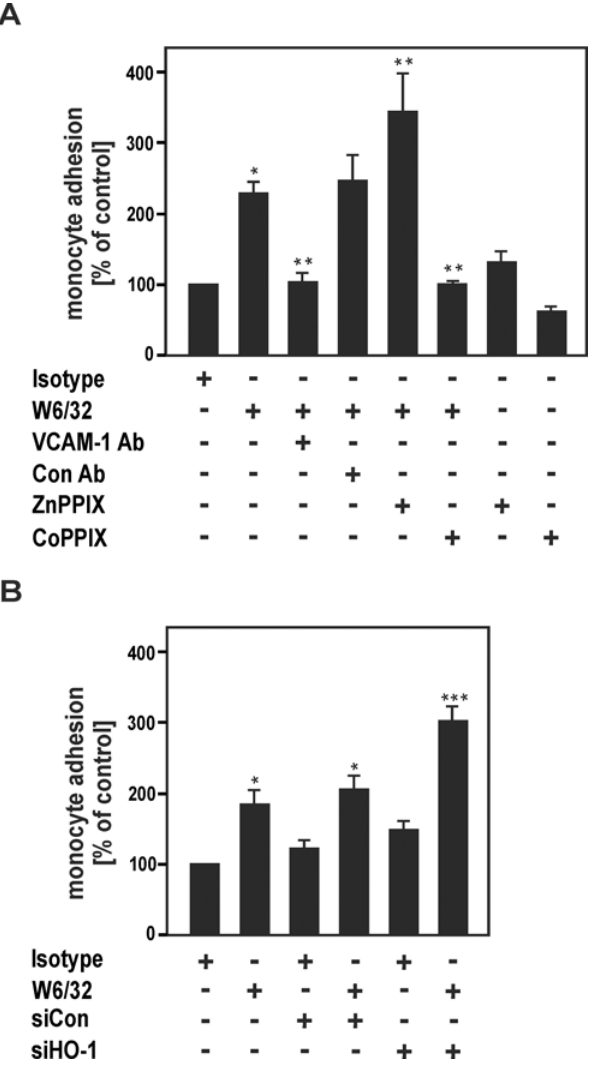
Fig 5. HO-1 modulates HLA I Ab-dependent up-regulation of THP-1 monocyte adhesion to HUVECs. (A) Confluent HUVECs were cultured for 24 h in the presence of MoAb W6/32 or isotype control Ab (10 μ g/ml) in the presence or absence of a blocking antibody against VCAM-1, a control Ab (Con Ab), ZnPPIX (5 μ M) and CoPPIX (5 μ M), as indicated. (B) HUVECs were transfected with siRNA for HO-1 or scrambled control siRNA, as indicated. After the various treatments in (A) and (B) cell cultures were incubated with Cell Tracker green-labeled THP-1 monocytes for 30 min. After 5 washing steps firmly adherent monocytes were quantified with fluorescence microscopy in 15 preselected high-power fields by a blinded investigator. The monocyte adhesion in % of control is indicated. Data are mean ± SEM from three independent experiments. * p (cid:3) 0.05, significant differences treatment versus control; ** p (cid:3) 0.05, W6/32 versus W6/32 plus anti-VCAM-1/ CoPPIX/ ZnPPIX; *** p (cid:3) 0.05, siCon plus W6/32 versus siHO-1 plus